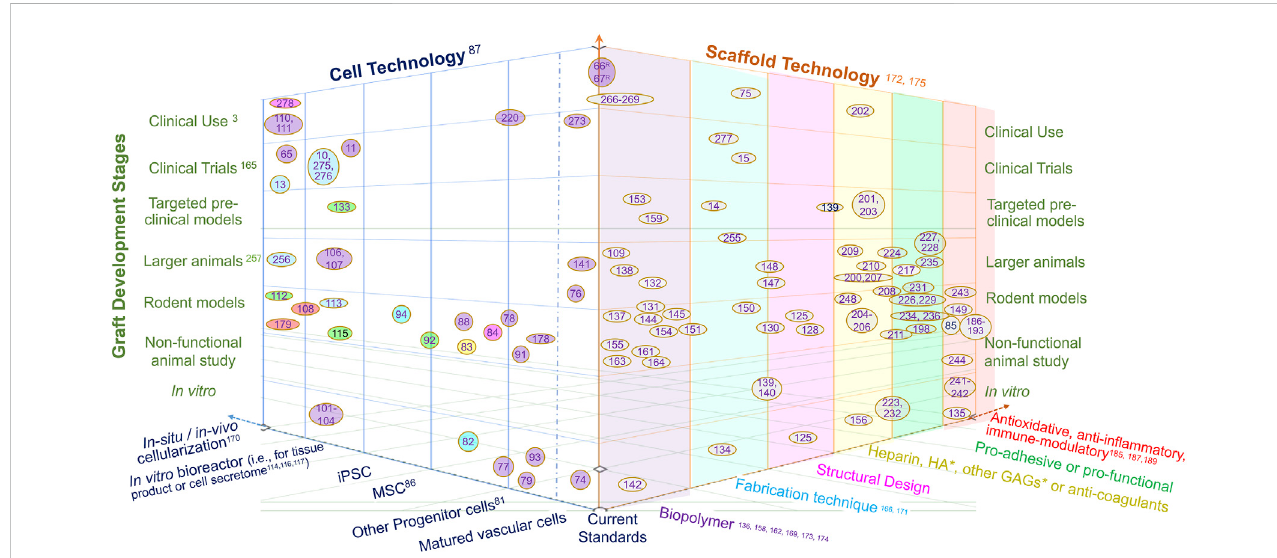
FIGURE 2 The landscape of vascular graft research in three dimensions, namely cell technology, scaffold technology and development stage. The citations of references used here are the numbered references listed in numerical order as they appear in the paper, as shown in Supplementary Material. The reference literatures are mapped in this landscape by locating research studies in the 3-dimensional space with reviews with various scopes labeled on the axes. The colors of oval boxes in the space of cell technology are correlated to the axis scaffold, showing the scaffold technology utilizied in these studies. Herein, “ Current standards ” refer to autologous graft (vein or artery) or bioinert graft (mostly PTFE-based); “ Targeted preclinical models ” refer to animal studies targeted at a clinical application such as dialysis access, Fontan graft, bypass for coronary, femoral or other arteries; “ Larger animal ” refer to animal models larger than rodents, such as rabbit, sheep, pig, dog and balloon; “ Non-functional animal study ” refer to non-vascular implants (often subcutaneous) or those used in ex vivo circulation; “ In situ or in vivo cellularization ” refer to the cellularization and/or tissue production by implanting acellular polymer; “ Matured vascular cells ” refer to vascular endothelial, smooth muscle and fi broblast cells; “ Other progenitor cells ” including endothelial progenitor cell and smooth muscleprogenitorcell; “ Biopolymer ” includesbiodegradablepolymer,biologically-derivedpolymer,decellularizedECMorvessel,bioinertpolymer,etc.*HA, hyaluronic acid; GAGs,